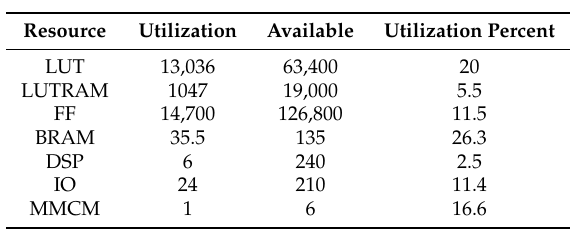
Table 2. Control unit